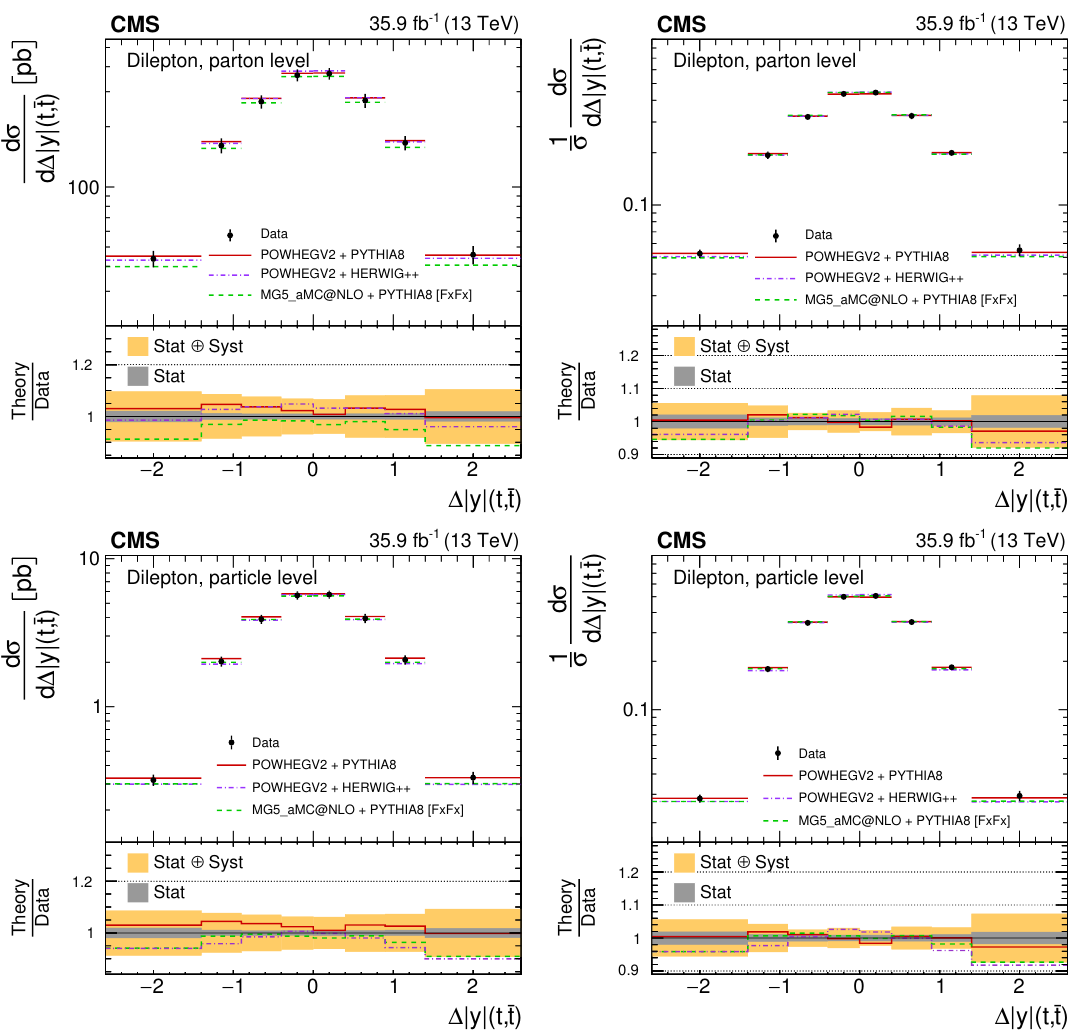
Figure 20 . The di(cid:11)erential tt production cross sections as a function of (cid:1) j y j (t ; t) are shown for the data (points) and the MC predictions (lines). The vertical lines on the points indicate the total uncertainty in the data. The left and right columns correspond to absolute and normalised measurements, respectively. The upper row corresponds to measurements at the parton level in the full phase space and the lower row to the particle level in a (cid:12)ducial phase space. The lower panel in each plot shows the ratios of the theoretical predictions to the data. The dark and light bands show the relative statistical and total uncertainties in the data, respectively.